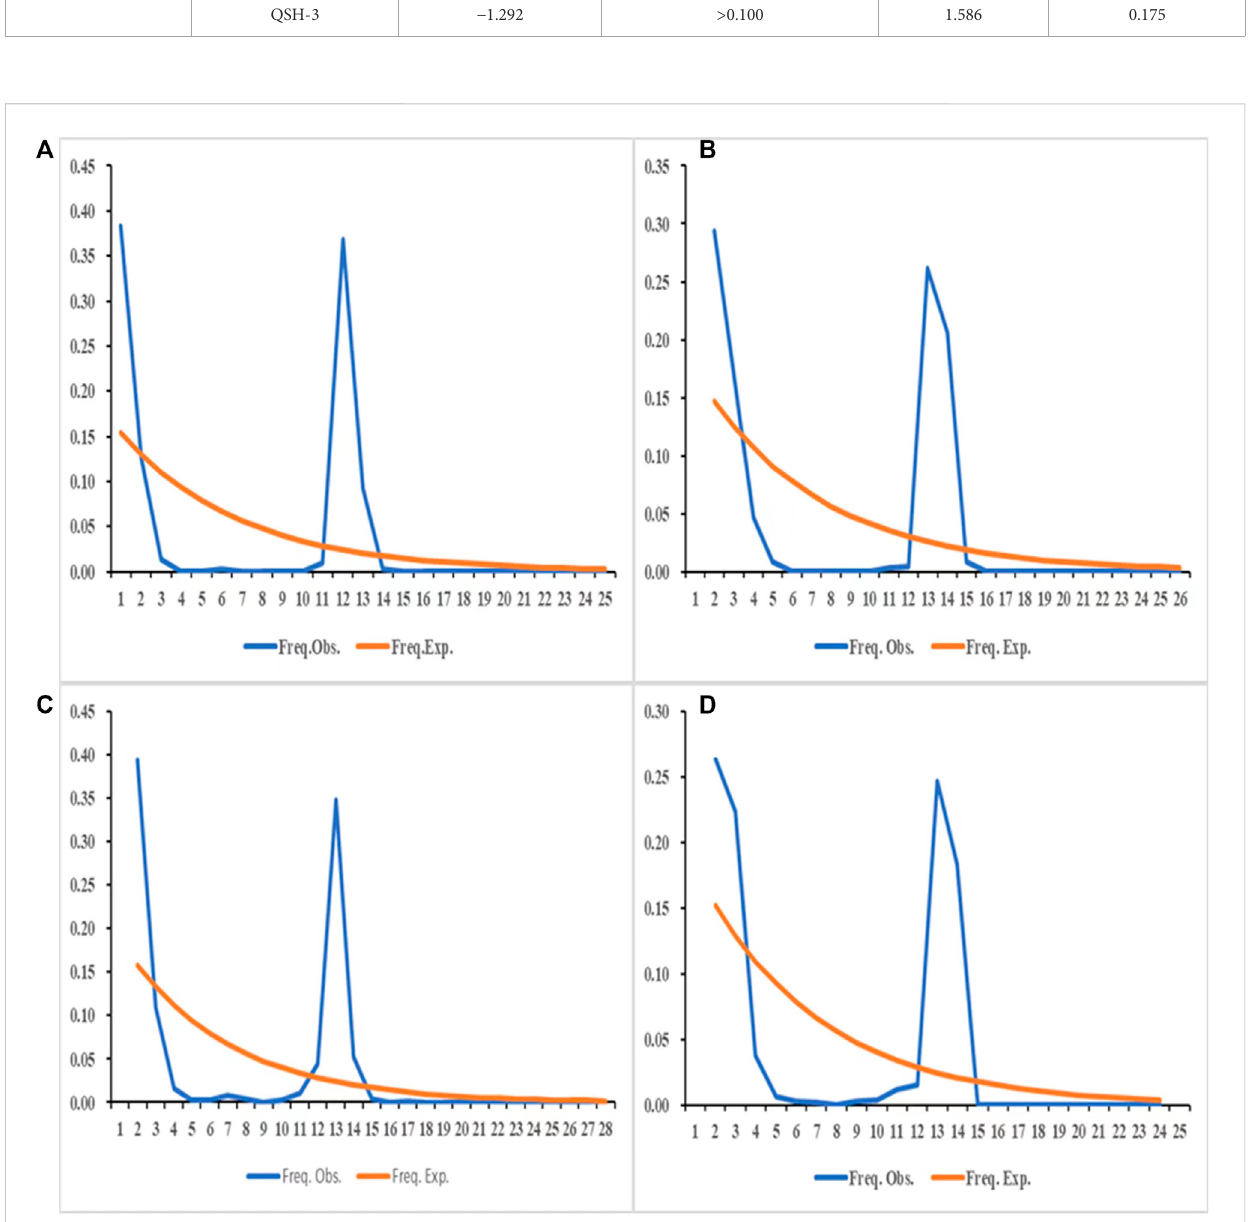
FIGURE 6 The distribution of the number of pairwise differences in COI and ND4 in 2019, 2020. (A) The distribution of the number of pairwise differences in COIin2019. (B) ThedistributionofthenumberofpairwisedifferencesinND4in2019. (C) ThedistributionofthenumberofpairwisedifferencesinCOIin 2020. (D) The distribution of the number of pairwise differences in ND4 in